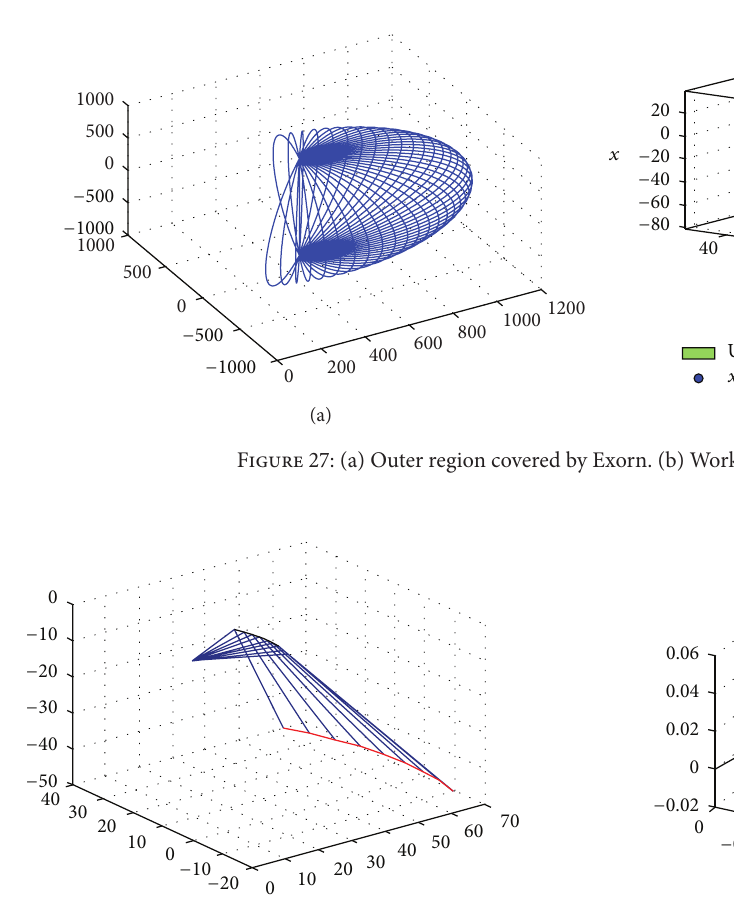
Figure 30: Motion due to shoulder joint and elbow joint movement in vertical direction.